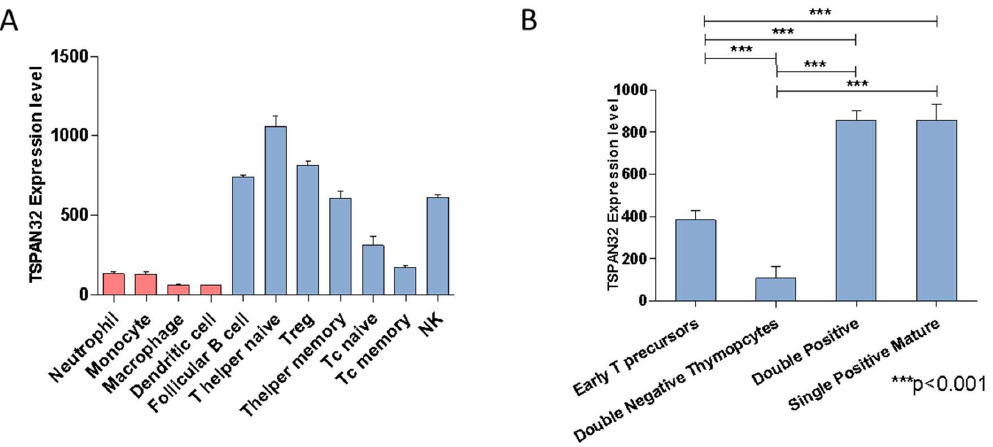
Figure 1. Expression of TSPAN32 in murine immune cells. ( A ) Expression of TSPAN32 in murine immune lineages was evaluated by interrogating the GSE15907 microarray dataset. ( B ) Modulation of the transcriptomic levels of TSPAN32 during T cell development, as determined from the GSE15907 dataset. Data are shown as normalized mean ± SD and statistical analysis performed using one-way ANOVA followed by Bonferroni multiple test correction.